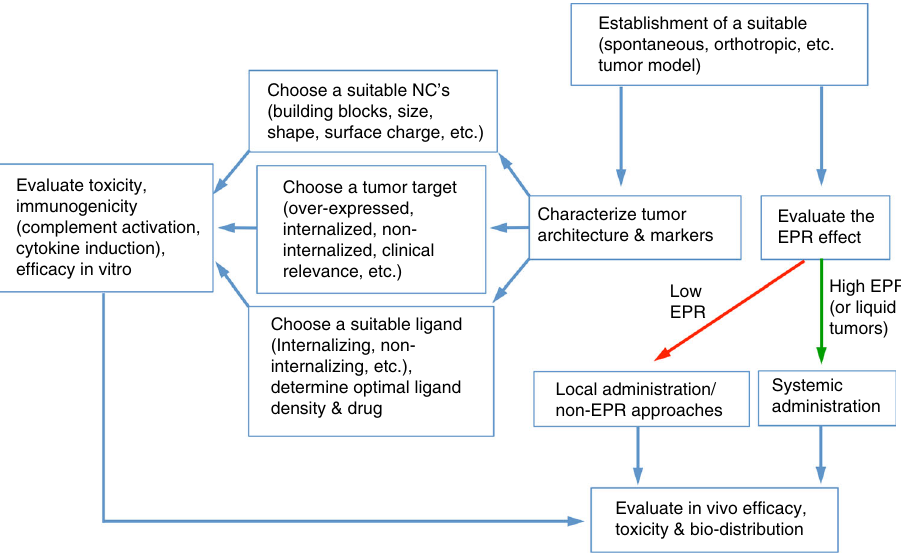
Fig. 3 Schematic illustration of the proposed work fl ow in the development of actively targeted